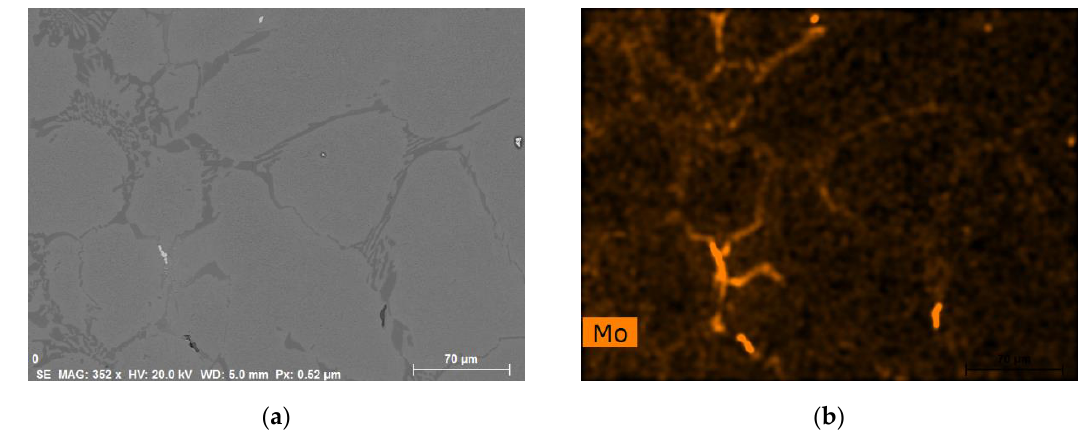
Figure 2. Initial Cr12 roller steel microstructure: ( a ) backscatter secondary electron (BSE) micrograph; ( b ) elemental distribution of Mo. Table 2. Approximate range of elemental content for primary and eutectic carbides, matrix and carbide/matrix band in wt. %.